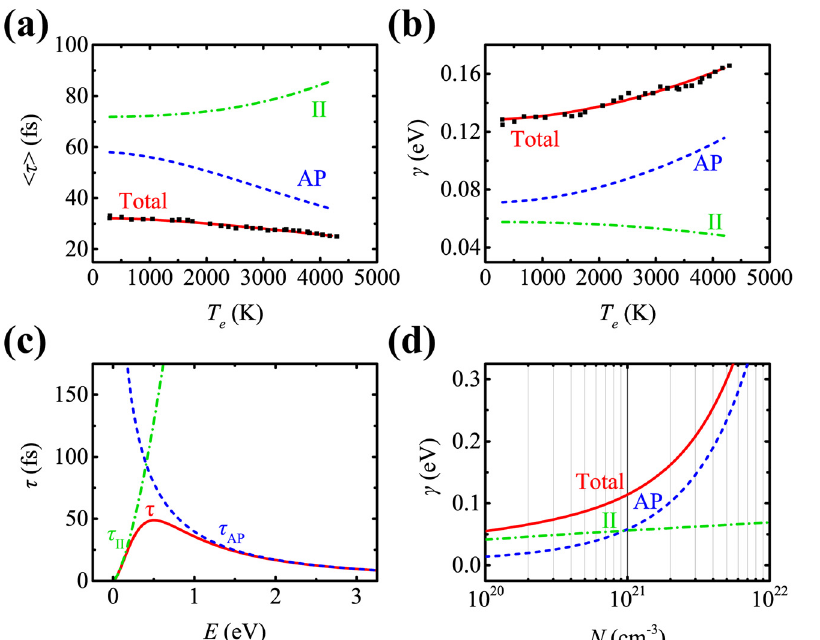
Figure 3: (a) Fitted 〈 τ 〉 ∼ T e relation and scattering time for acoustic phonon (AP) scattering and ionized impurity (II) scattering. (b) Calculated γ ∼ T e relation and contribution for acoustic phonon (AP) scattering and ionized impurity (II) scattering. (c) Electron energy – dependent scattering time τ ( E ) , τ AP ( E ) , and τ II ( E ) . (d) Electron density N dependent damping factor γ at T e (cid:1) 300 K with the contribution for AP and II acts as the donor of free carriers. As shown by simulation for zero pumping, the contributions of acoustic phonon scattering and ionized impurity scattering vary with N (Figure 3d) and are equal at N c (cid:1) 0 . 95 × 10 21 cm − 3 . The re- sults shown in Figure 3d indicate the N -dependency of γ ;